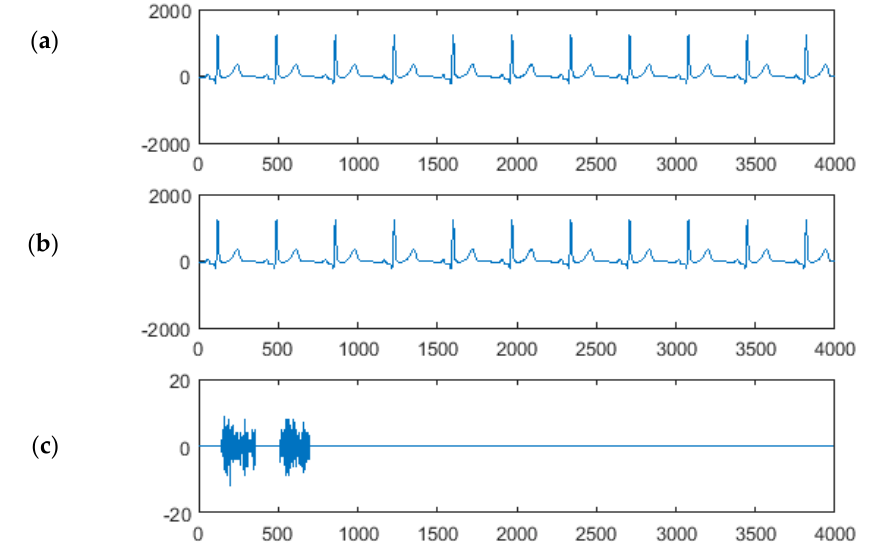
Figure 2. Irreversible watermarking process ( a ) watermark embedment; ( b ) watermark extraction.